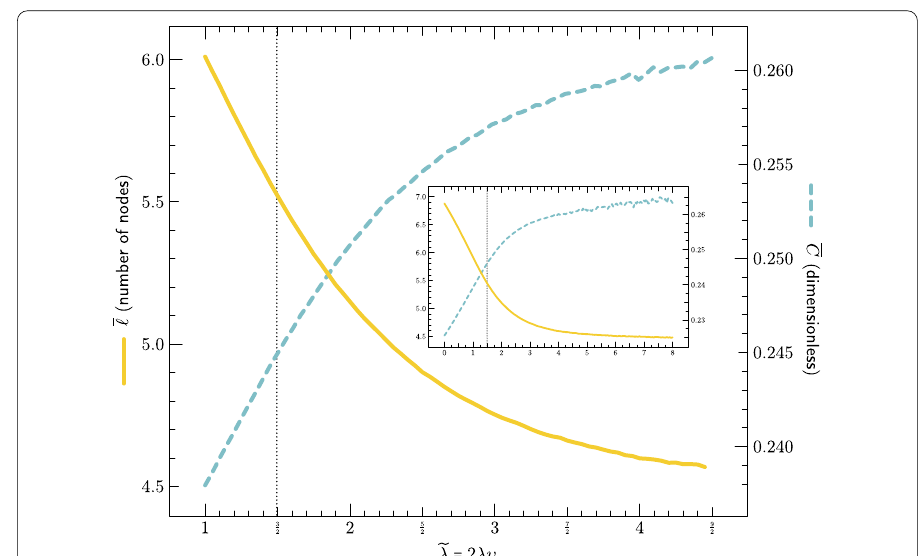
Fig. 8 Mean geodesic distance between nodes and mean local transitivity versus effective scaling exponent for the information networks of Central London (United Kingdom): yellow solid line plots the mean of the mean geodesic distance between node pairs ℓ ; turquoise dashed line plots the mean of the mean local transitivity C ; the vertical dotted line represents the effective scaling exponent Metropolis equilibrium approaches on average self-fit outputs—as illustrated in Fig. 6d; the inset shows their asymptotic behaviours; the main figure and the inset have the same aspect ratio. The experimental protocol was the same as in Fig. 7. (We attribute the noise to the same reasons as in Fig.